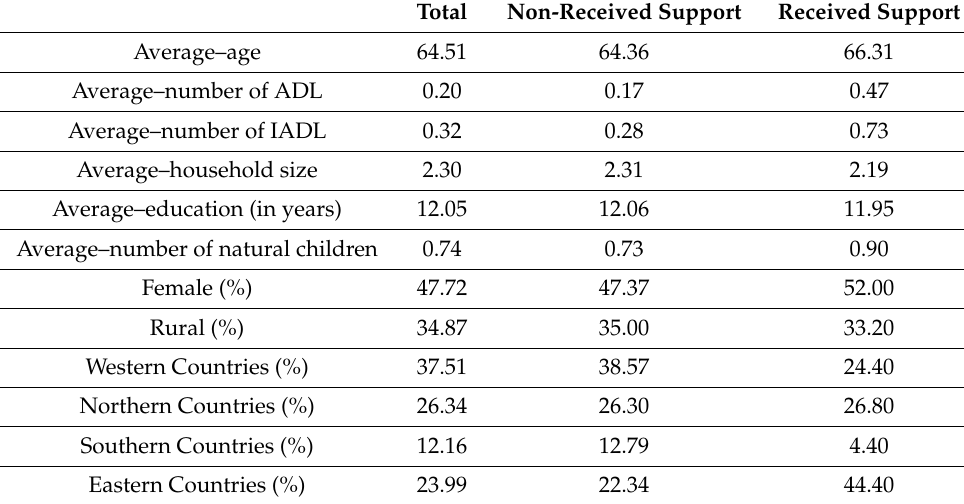
Table 2. Descriptive statistics of respondents with at least one stepchild, by non-financial